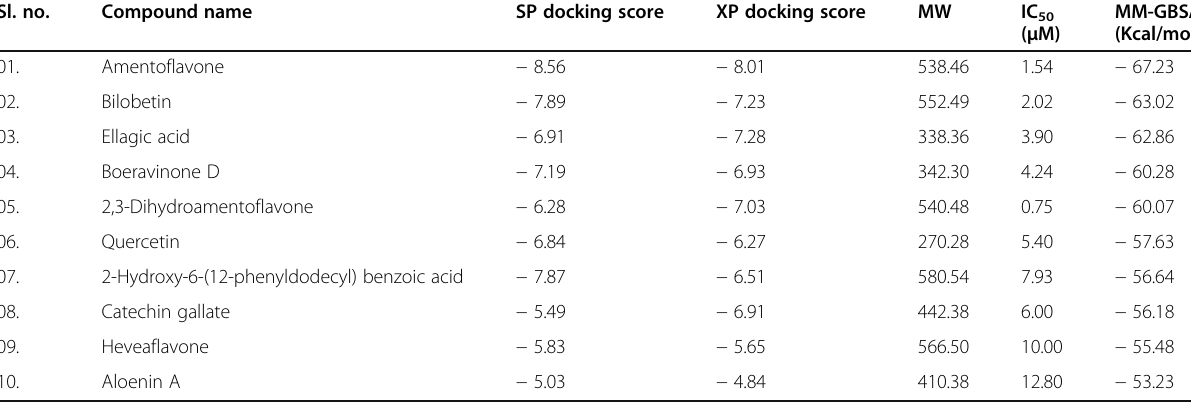
Table 2 Result of SP and XP docking and free binding energy calculation of selected ligands Sl.